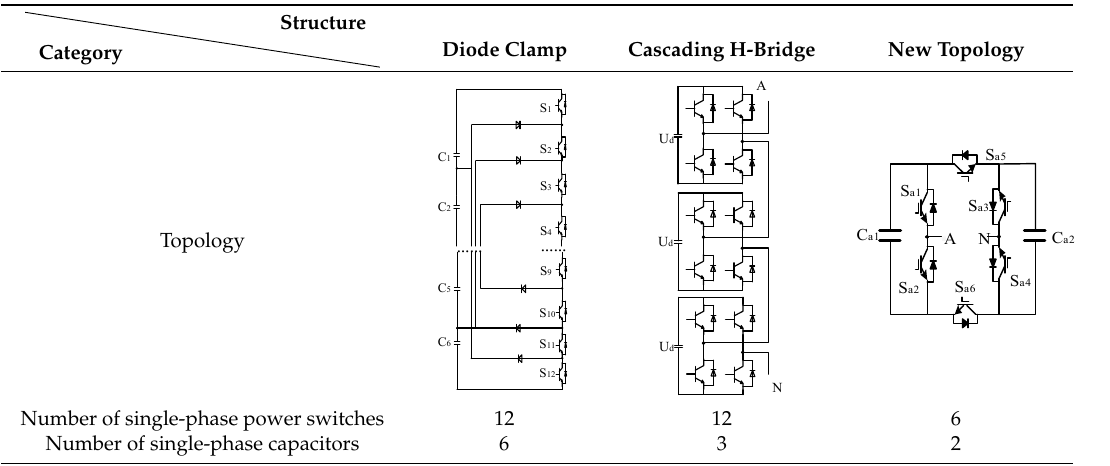
Table 2. Seven-level topology comparison.